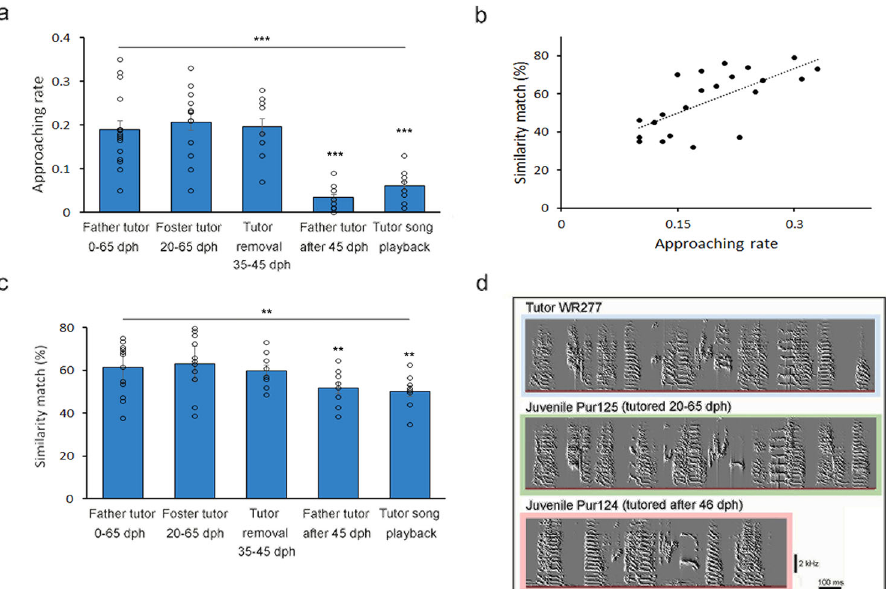
Fig. 2 Development of juvenile ’ s listening/approaching behavior requires previously acquired tutor memory, and individual variation in attention behavior was associated with the precision of song imitation. a Juveniles who were socially tutored from 0 to 65 dph or 20 to 65 dph, or experienced tutor removal from 35 to 45 dph and then were re-exposed to the same tutor at 46 dph, had signi fi cantly more listening/approaching behavior toward their tutors during 46 – 55 dph ( n = 23 birds; one-way ANOVA, F 4,23 = 5.71, *** P < 0.001; Tukey post hoc test, tutored 0 – 65 dph vs. tutored after 45 dph or tutor song playback, P < 0.001) than juveniles who were not exposed to adult tutors until after 46 dph ( n = 8 birds) or juveniles who received the speaker playback of the same tutor song ( n = 8 birds). Blue bars represent the mean approaching rate with standard error. Each dot represents an individual bird ’ s approaching rate. b Juvenile males ( n = 23, each black dot represents one individual bird) who had a higher approaching rate also developed a better match of tutor song imitation ( R 2 = 0.56). The approaching rate depicts the mean number of approaches/number of tutor songs. c Juveniles who were socially tutored from 0 to 65 dph, 20 to 65 dph, or experienced tutor removal from 35 to 45 dph, had better imitation of tutor song, compared to juveniles who were not exposed to adult tutors until after 46 dph ( n = 8 birds), or juveniles who received playback of the same tutor song ( n = 8 birds; one-way